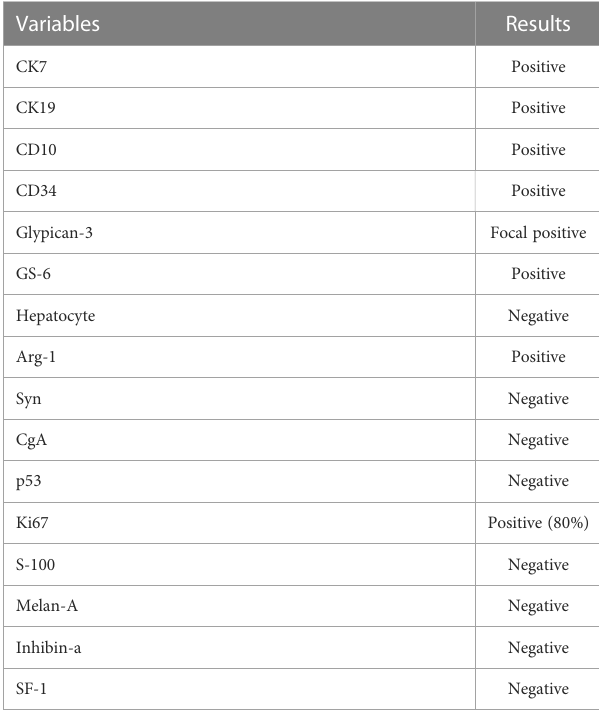
TABLE 1 Details of immunohistochemical staining of the resected tumor specimen. Variables